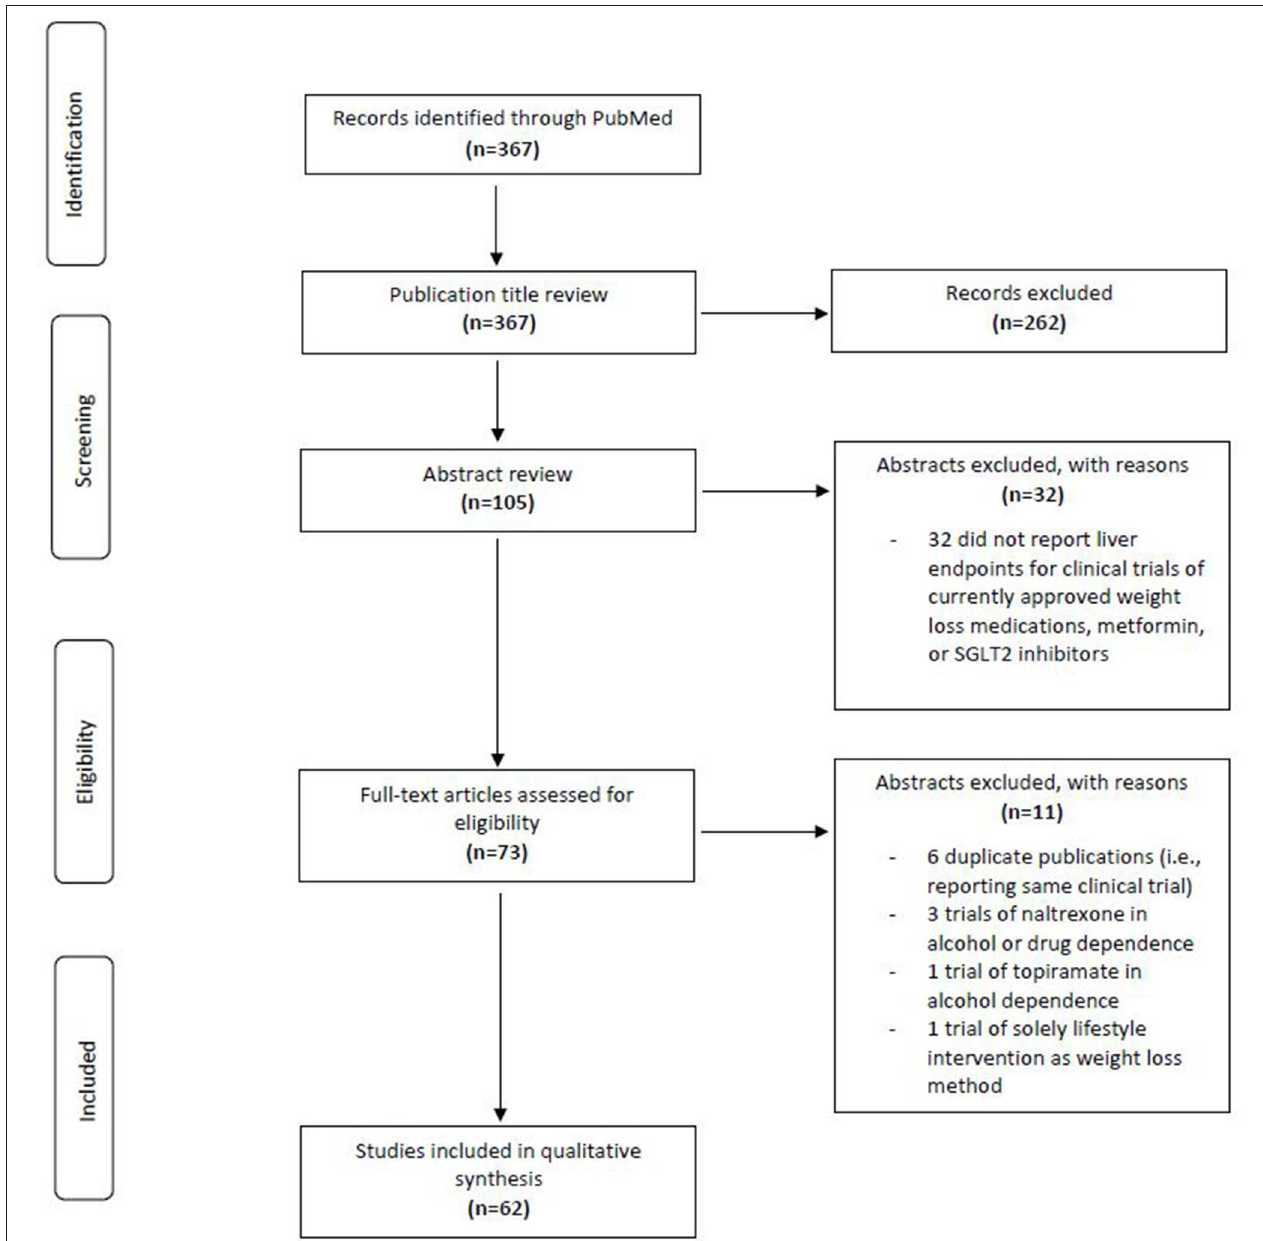
FIGURE 1 | Preferred Reporting Items for Systematic Reviews and Meta-Analyses (PRISMA) diagram describing the selection of relevant publications for the review.